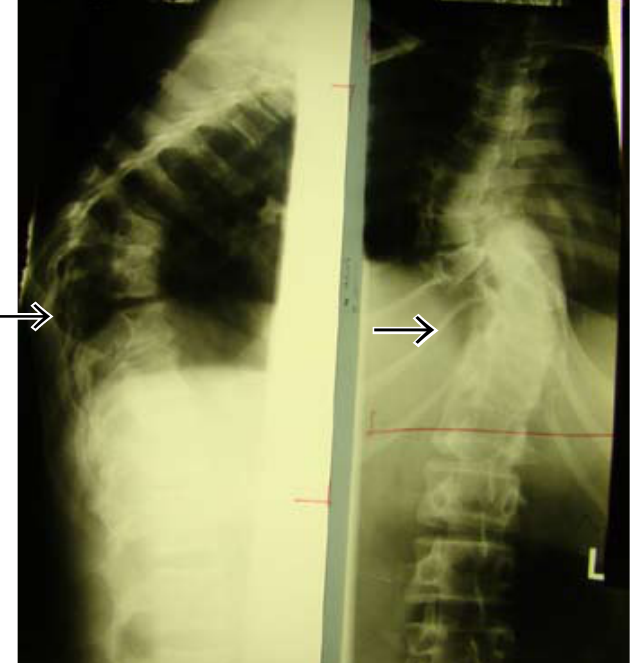
Fig. 9a. Lateral and frontal X-rays of the thoracic spine demonstrating kyphoscoliosis, which may be due either to vertebral anomalies or to large meningoceles or neurofibromas.